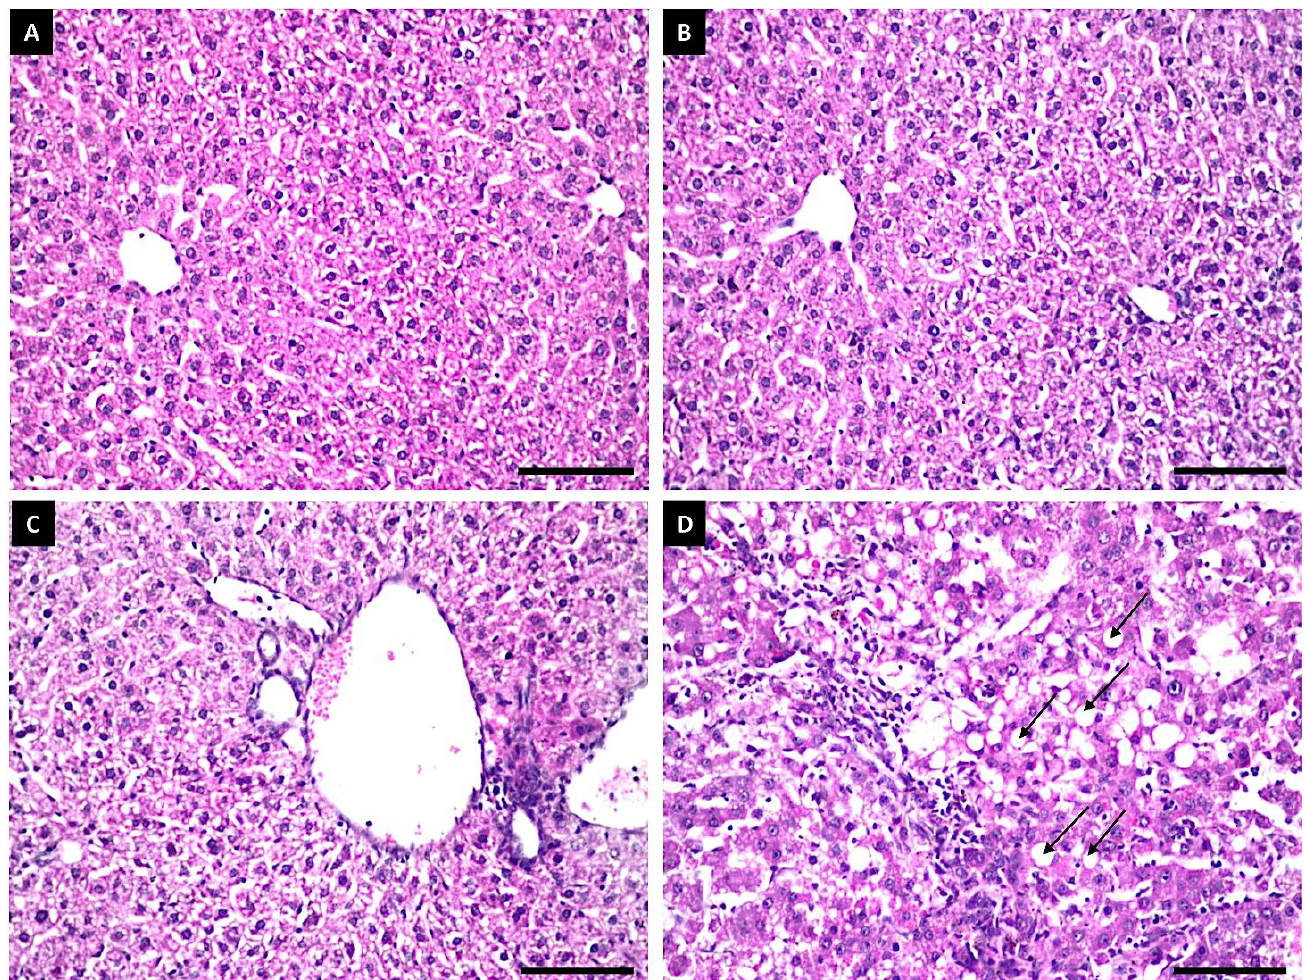
Figure 6. Histopathological changes in the livers of male albino rats fed with grain sorghums treated with Fe 3 O 4 /HA NPs; no histopathological changes were recorded in the hepatocytes and central vein of control (untreated) and treated with 10 mg L − 1 rats ( A , B ); few inflammatory cells infiltration and dilatation in the portal vein of rats exposed to 40 mg L − 1 Fe 3 O 4 /HA NPs ( C ); massive inflammatory cells infiltration was detected in between the fatty changed hepatocytes all over the parenchyma (black arrow) of rats exposed to 80 mg L −1 Fe 3 O 4 /HA NPs ( D ). Scale bar represents 100 μ m.